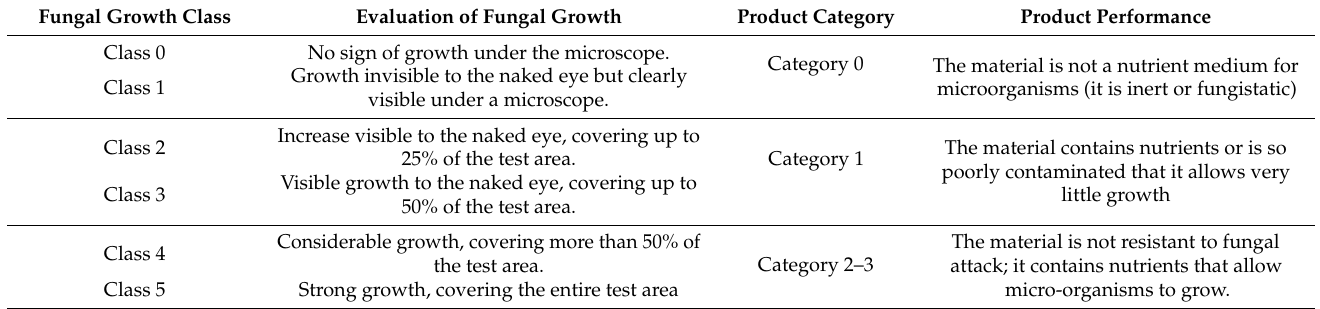
Table 2. Criteria for assessing mould resistance.